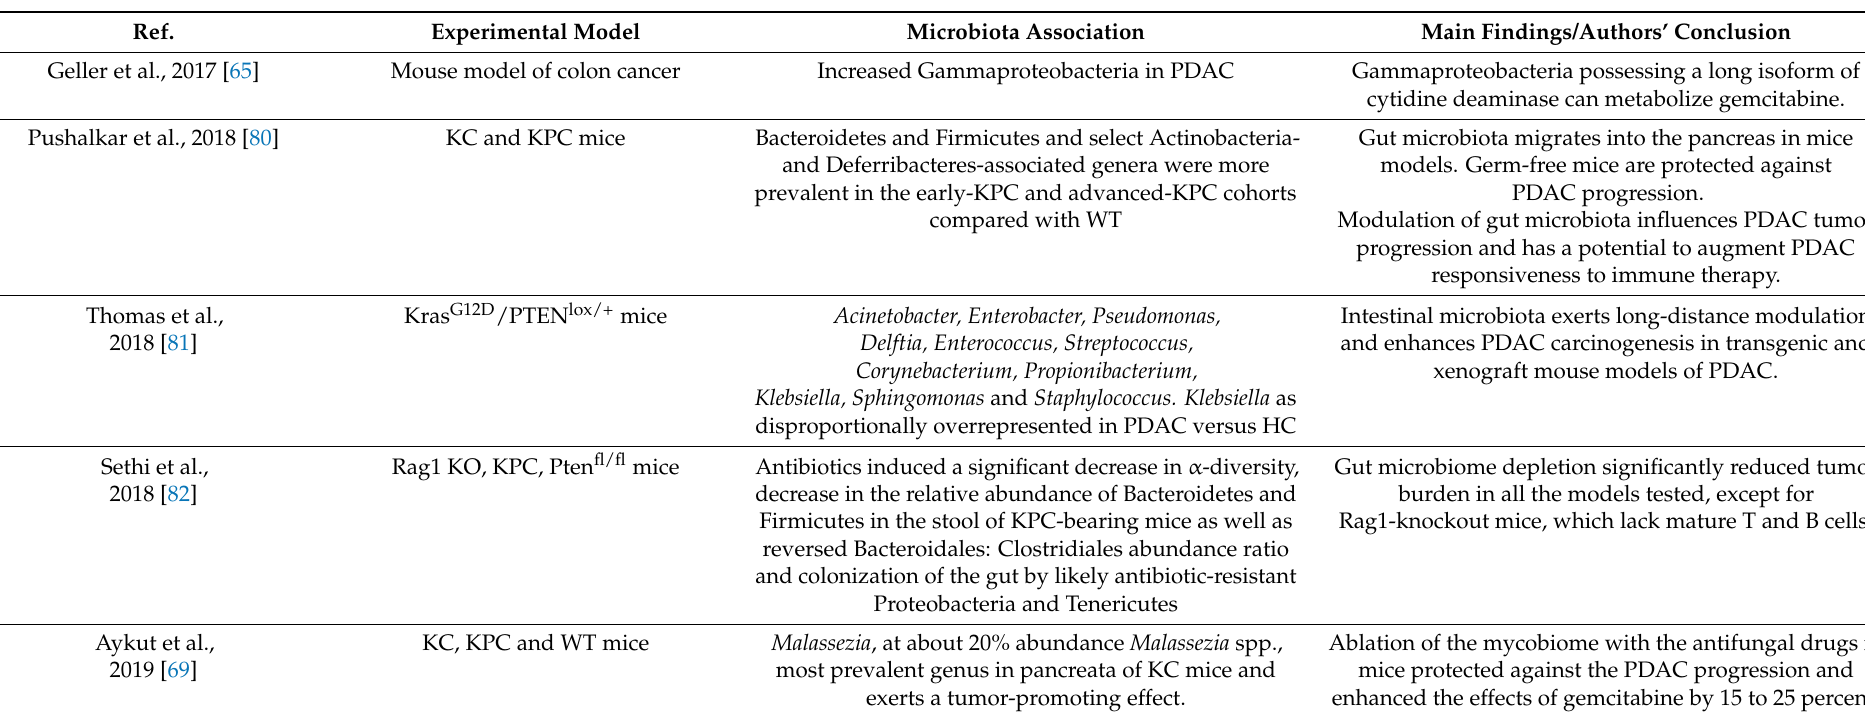
Table 4. Studies on animal models; KC mice: p48 Cre ; LSL-Kras G12D . KPC mice: Pdx1 Cre ; LSL-Kras G12D ; p53R 172H ; Rag1. KO: C57BL/6J mice carrying a Rag1 tm1Mom . WT: wild-type.